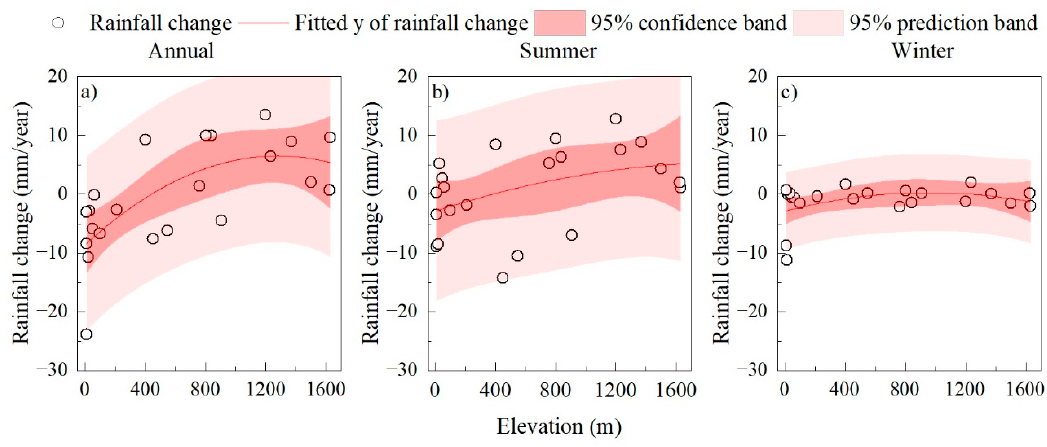
Figure 6. Trend magnitude of ( a ) annual rainfall, ( b ) summer rainfall and ( c ) winter rainfall according to elevation. Open circles, dark panels, light panel, and solid line indicate calculated values, 95% confidence band, 95% prediction band, and best curve-fit line, respectively.